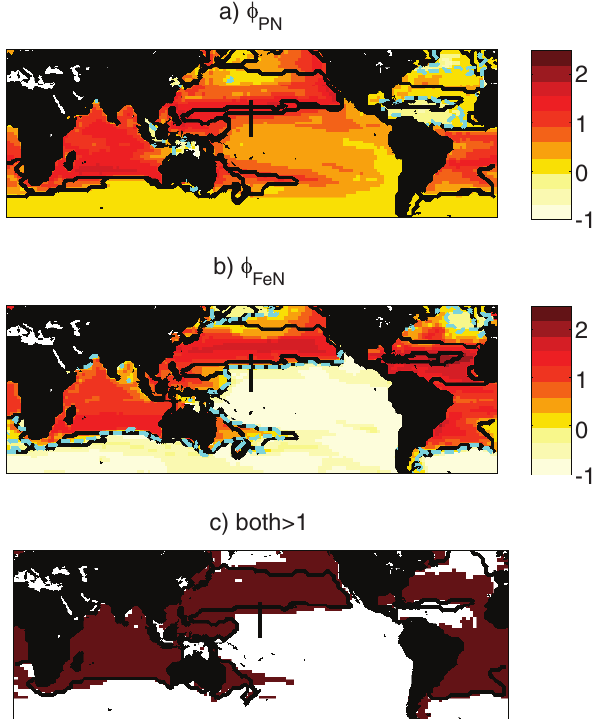
Figure 5. (a, b) Nutrient supply ratios (log unitless, annual av- erage) into the surface 100m of the numerical model for pre- I ∗ P industrial conditions (experiment Control ). (a) φ PN = and R NPB I ∗ N I ∗ Fe (b) φ FeN = . Dashed blue line bounds regions where both R NFeB I ∗ N φ PN > 1 and φ FeN > 1 in (a) . Black contours indicate the province boundaries in Fig. 3a. Black line in Pacific indicates the transect show in Figs. 4 and 8. (c) Brown shaded region indicates where both φ PN > 1 and φ FeN > 1, minimum conditions needed to support dia- zotrophs. Black contour indicates region which do have diazotrophs (compare to Fig.